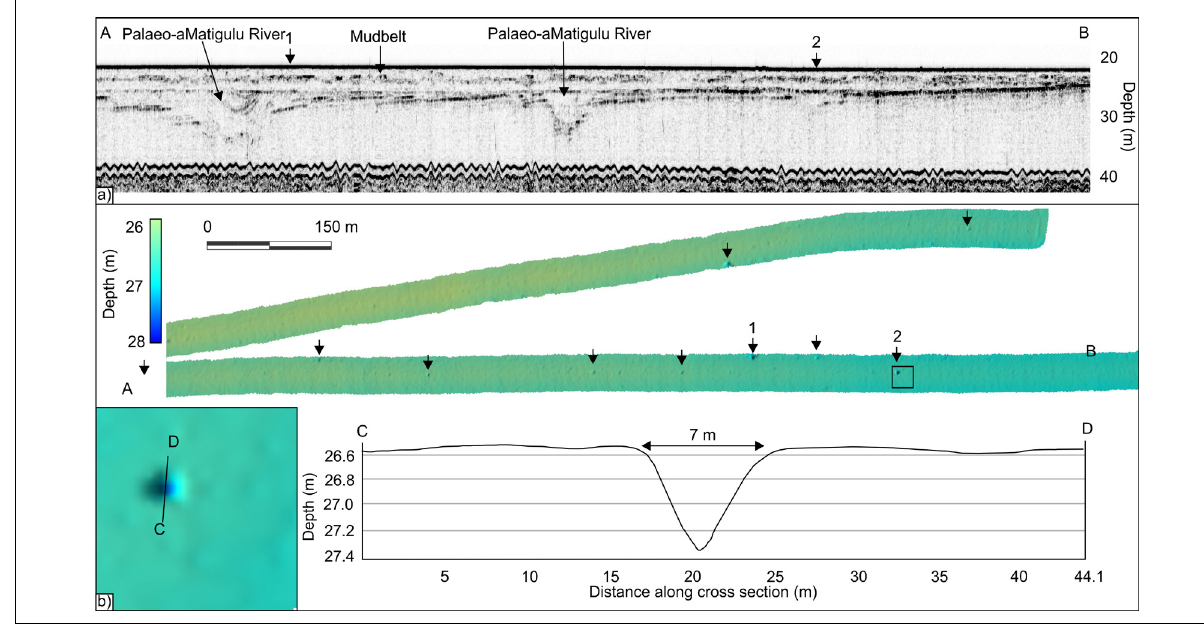
Figure 7: (a) Coast parallel seismic reflection profile offshore the aMatigulu Estuary. Note the occurrence of two prominent river channel meanders which incise by almost 20 m. (b) Corresponding multibeam image of the inner shelf; black arrows highlight pockmarks along the seabed. 1 and 2 are shown in the seismic reflection profile in (a). Cross section C to D highlights a typical pockmark (square and